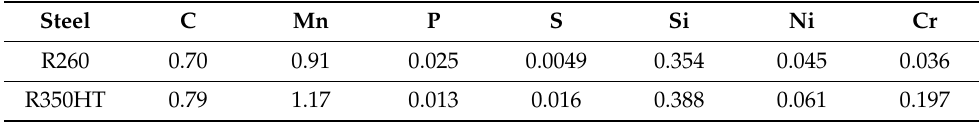
Table 2. Chemical composition of R260 and R370HT steel.